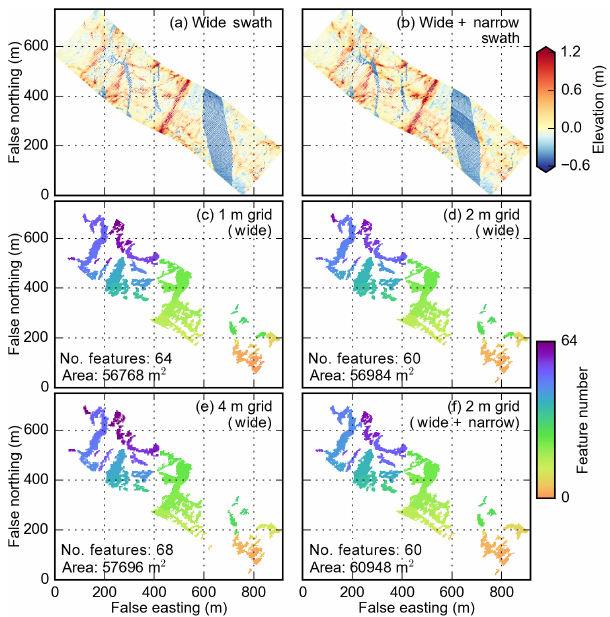
Figure 4. Example feature detection algorithm for a 1km ATM sec- tion in 2011. The top row shows the raw ATM data from both the regular wide scan (a) and from the combined wide and narrow scan (b) . Panels (c–e) show the features detected using a 1m (c) , 2m (d) and 4m (e) gridding of the regular wide scan ATM data, while (f) shows the results from the 2m gridding of the combined wide and narrow scan ATM data. Panels (c–e) also show the number of surface features ( > 20cm) detected and the total area of these fea-